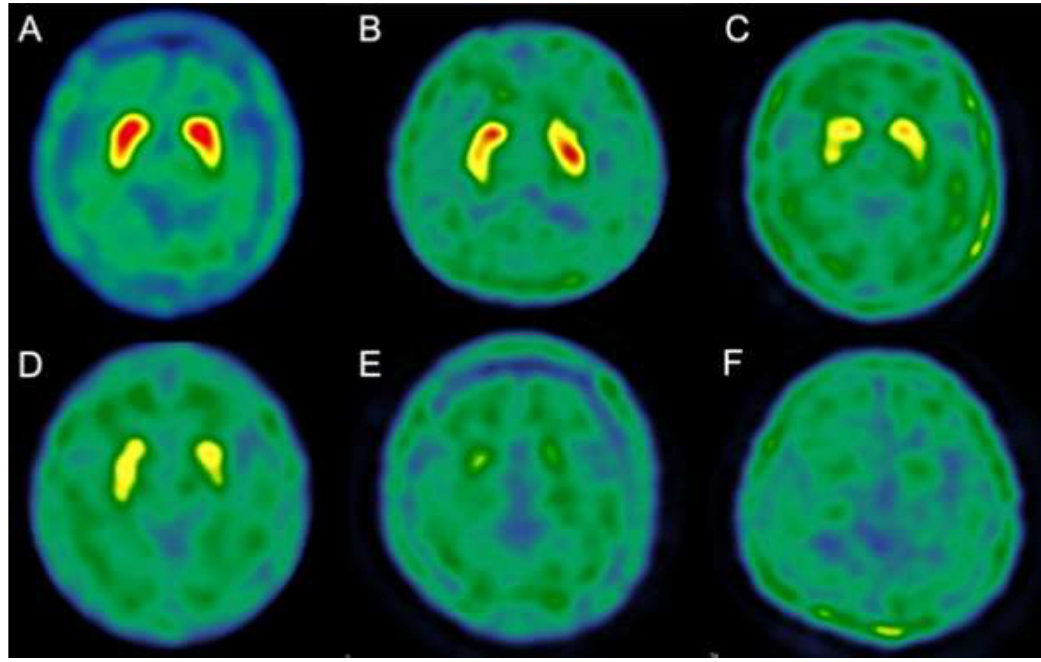
Figure 2. Different staging of 99 m Tc-TRODAT-1 SPECT for patients with iNPH. A. Normal. B. Stage 1. C. Stage 2. D. Stage 3. E. Stage 4. F. Stage 5. A higher stage implies a greater loss of dopaminergic